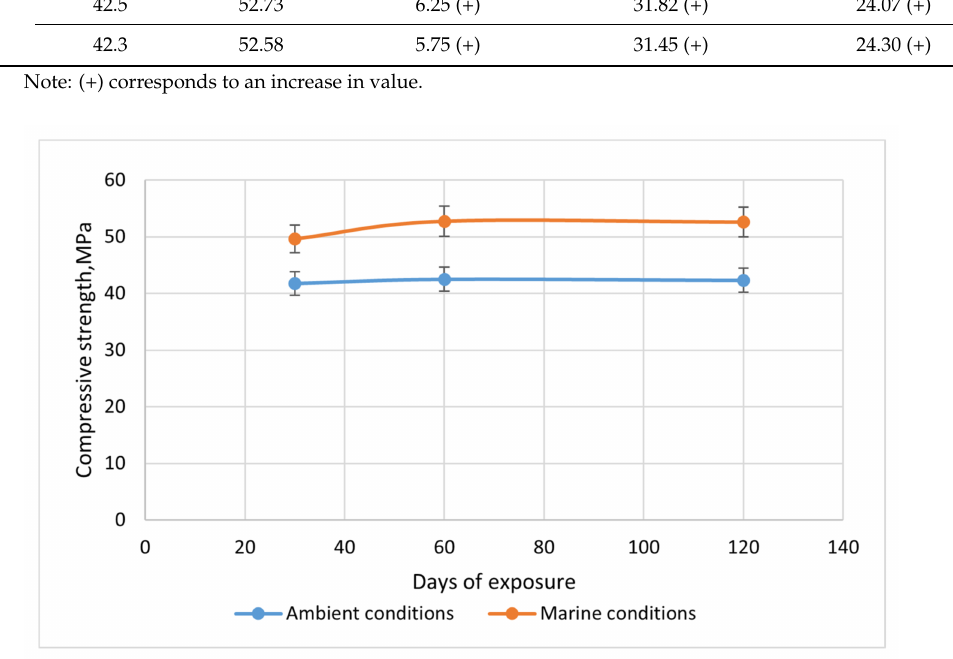
Figure 7. Compressive strength of ambient and marine exposed